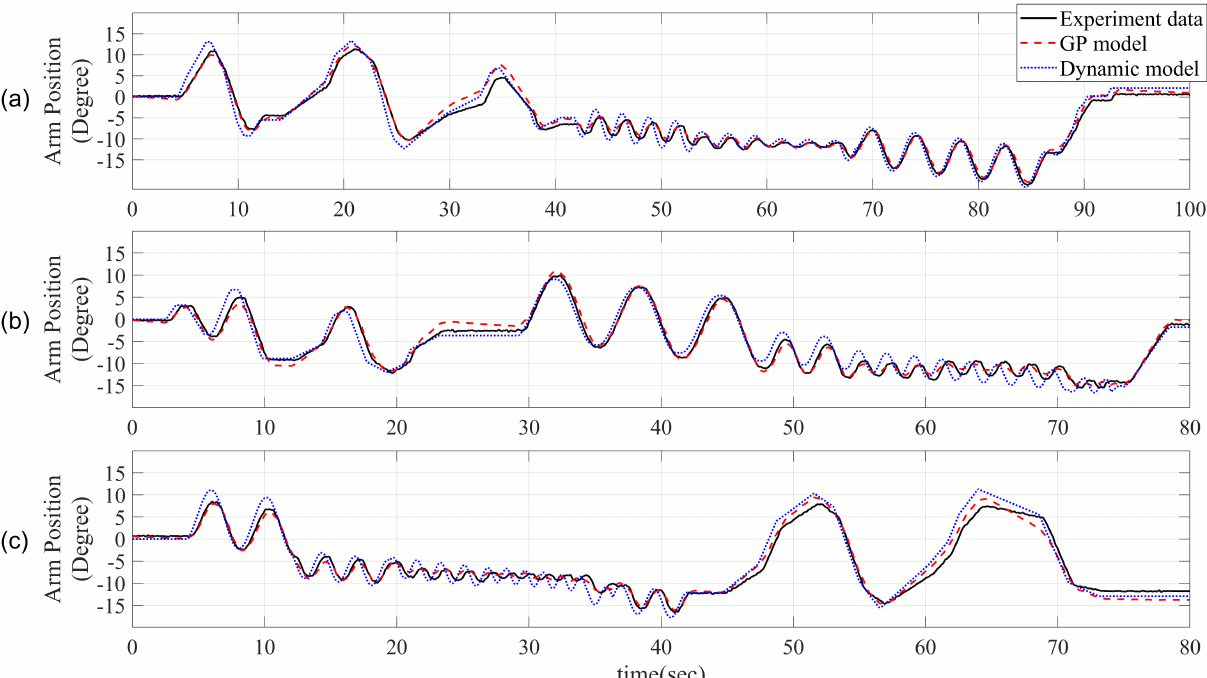
Figure 12. Arm speed obtained using experiment, GP model, and dynamic models for ( a ) first validation input command set, ( b ) second validation input command set, and ( c ) third validation input command set.